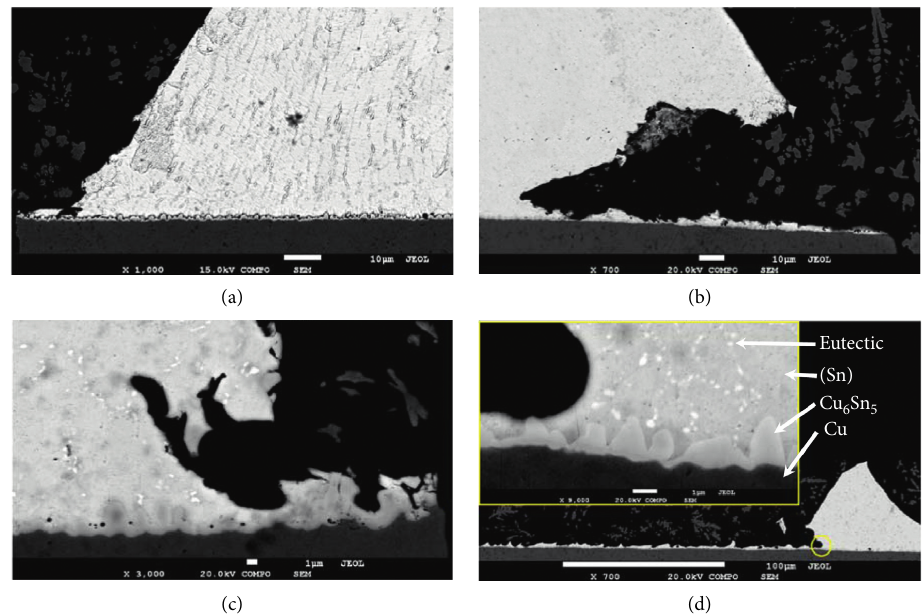
Figure 9: Microstructures of tested soldered joints made by reflow soldering of SAC038 (a), SAC108 (b), SAC158 (c), and SAC357 (d) solder